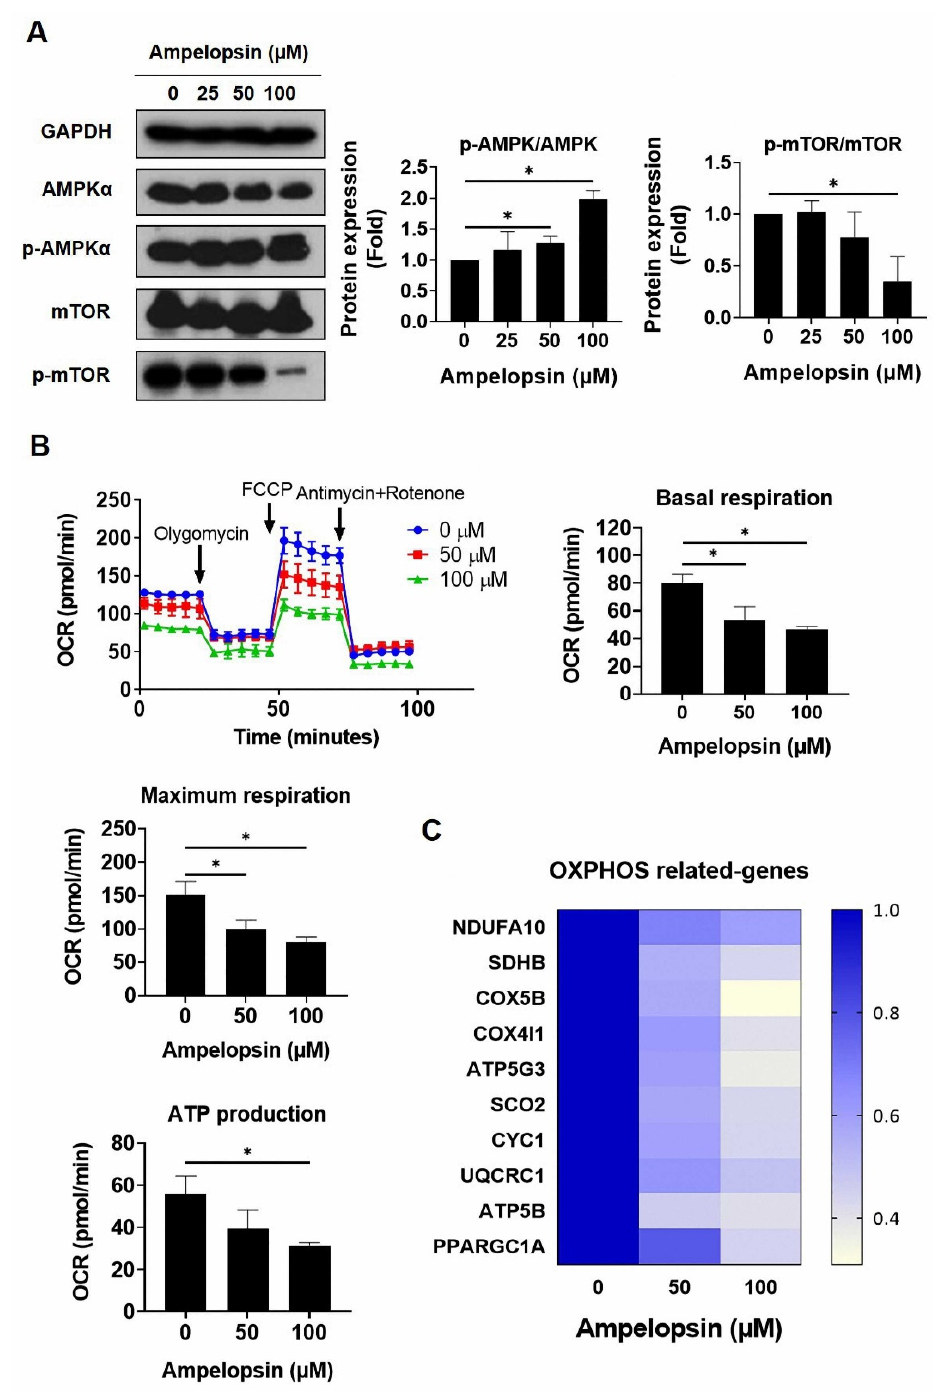
Figure 4. Assessment of oxidative phosphorylation in MDA-MB-231/IR cells after ampelopsin treatment. ( A ) Levels of AMPK α , p-AMPK α , mTOR, and p-mTOR were examined by Western blotting analysis after 24 h incubation with ampelopsin. Original films were shown in Figure S6. ( B ) Seahorse XF analysis was performed to measure OCR, ATP production, basal respiration, and maximum respiration after ampelopsin treatment for 24 h. Cells were cultured in XF assay medium supplemented with pyruvate (1 mM), glucose (10 mM), and L -glutamine (2 mM), and then treated with oligomycin (2 µ M), carbonyl cyanide- p trifluoromethoxyphenylhydrazone (1 µ M), antimycin (1 µ M), and rotenone (1 µ M). ( C ) Real-time PCR analyzed the expression of OXPHOS-related genes. * p < 0.05 vs.